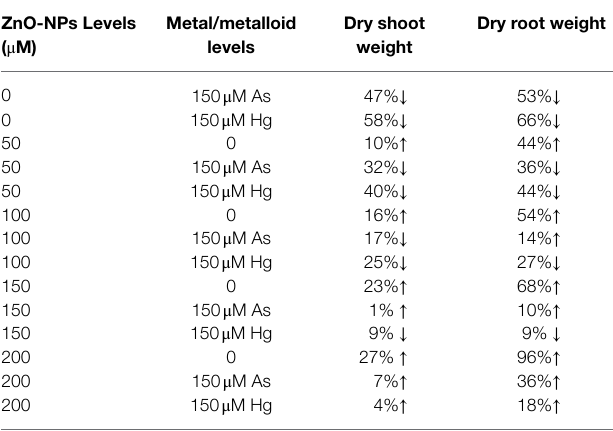
TABLE 2 | The percent changes of bamboo biomass in shoot and root dry weight at various levels of ZnO-NPs in combination with 150 μ M As and 150 μ M Hg compared to those of the control treatment